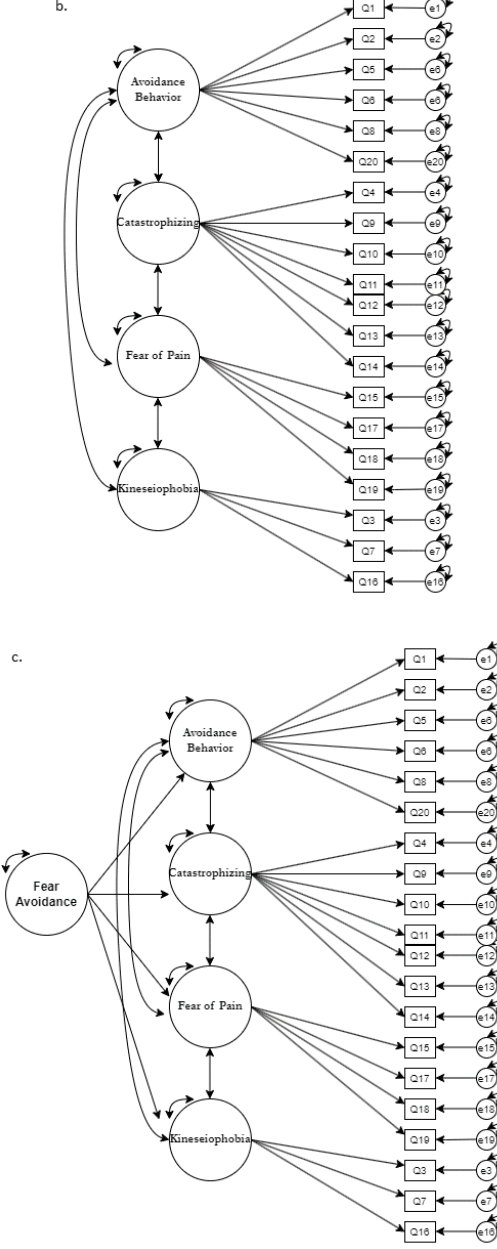
Figure 1. Competing Confirmatory Factor Analysis Models: ( a ) base model, ( b ) four-factor model, ( c ) second-order model.